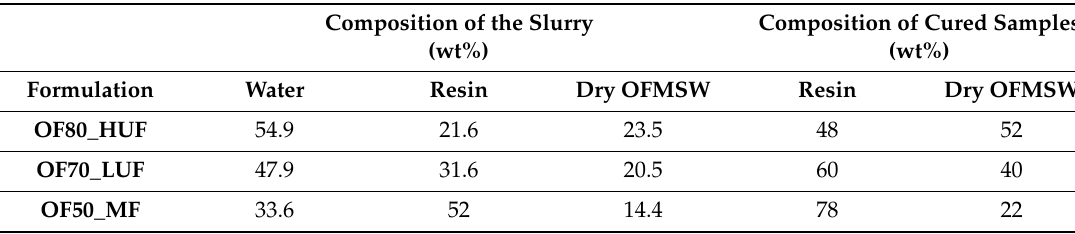
Table 1. Composition of the blends: OF80_HUF sample is a blend with 80% of wet OFMSW inertized in 20% of HUF resin, OF70_LUF refers to blend with 70% of wet OFMSW and 30% of LUF resin, finally OF50_MF is a blend with 50% of wet OFMSW and 50% of MF resin.